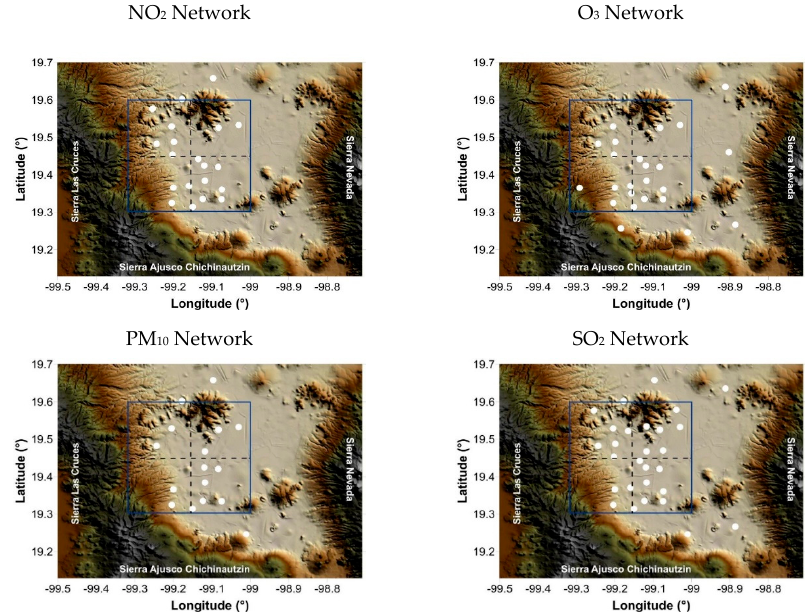
Figure 3. Spatial distribution of the stations (white dots) of the NO 2 , O 3 , PM 10 , and SO 2 monitoring networks (RAMA) of SIMAT. The RAMA provides 1-hour average values of the surface concentrations of NO 2 , O 3 , PM 10 , and SO 2 , among other chemical